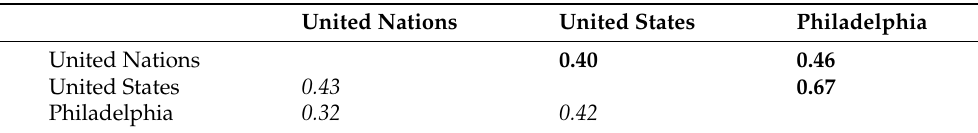
Table 5. Correlation of relevance for the three documents. The correlation for relevance of concepts is shown in bold font above the main diagonal, while the correlation for relevance of relationships is shown in italic font below the main diagonal. United Nations United States Philadelphia United Nations 0.40 0.46 United States 0.43 0.67 Philadelphia 0.32